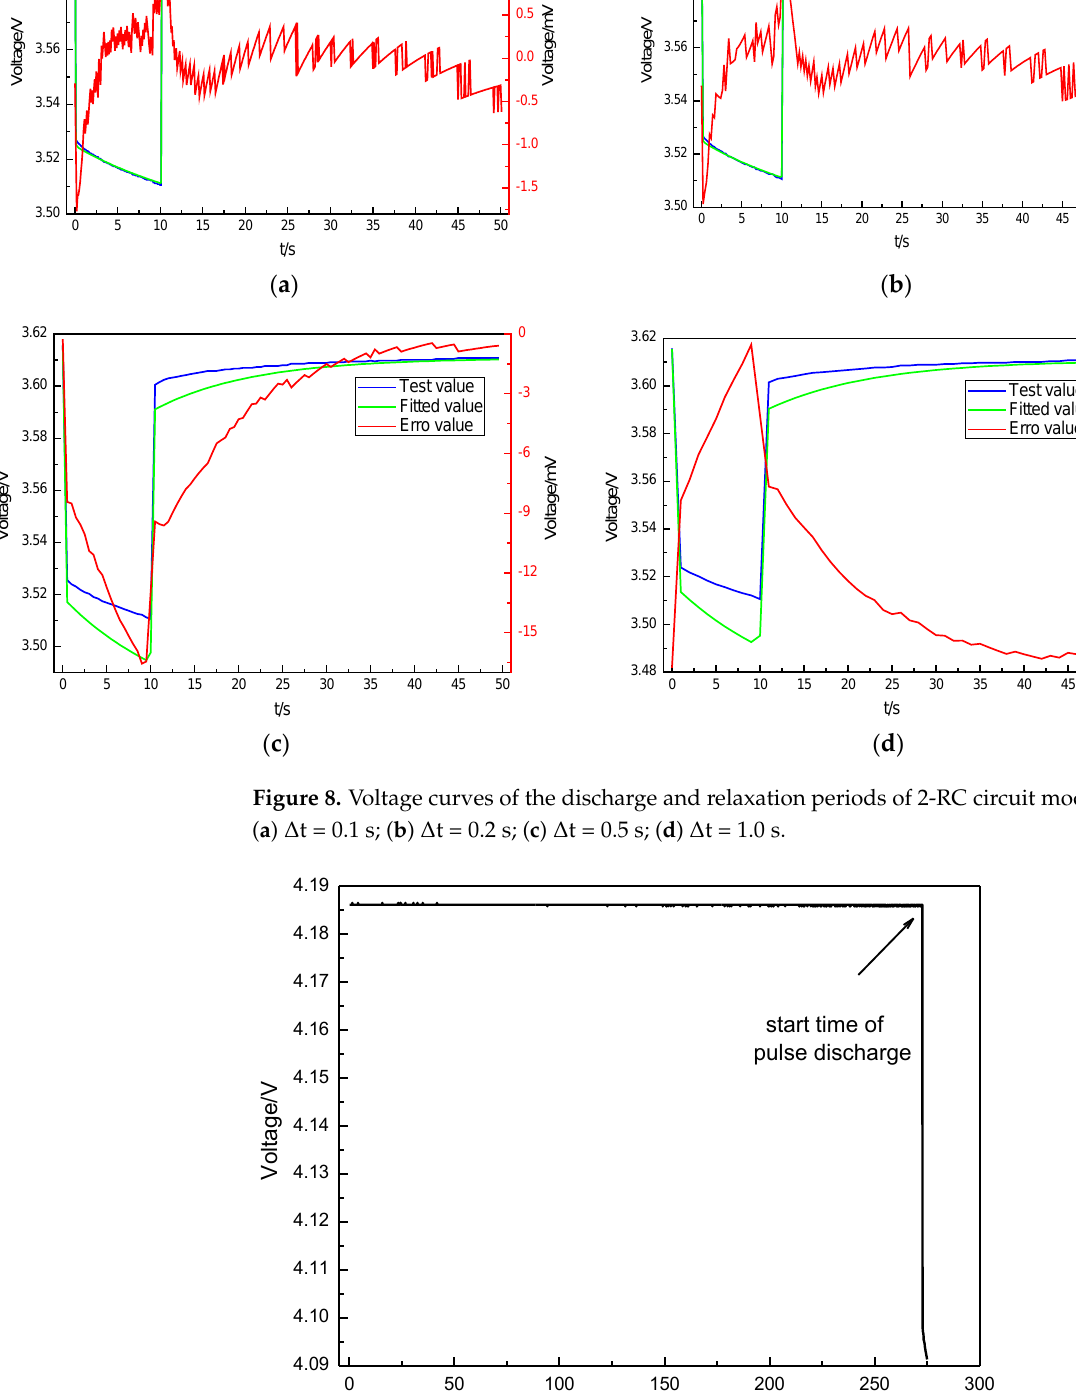
Figure 9. Voltage over time of the rest period before the first pulse discharge.